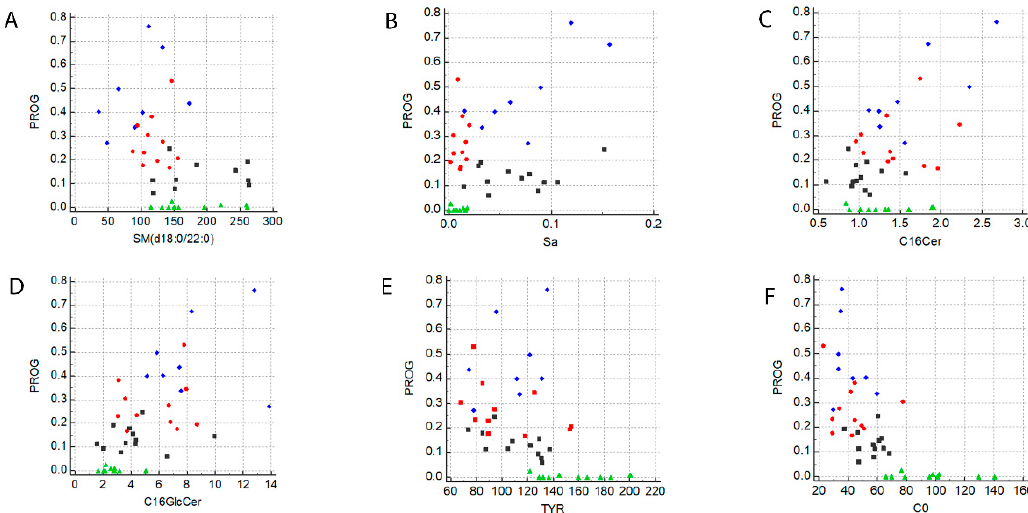
Figure 5. Panels ( A – F ) show the Rank correlations, performed by using MedCalc 7.6, between Progesterone (PROG), Sphingomyelin (d18:0/22:0) (SM), Sphinganine (Sa), Ceramide (d18:1/16:0) (C16Cer), Glucosylceramide (d18:1/16:0) (C16GlcCer), Tyrosine (TYR) and Free Carnitine (C0), respectively. The black squares indicate the first trimester of pregnancy, the red circles indicate the second trimester of pregnancy, the blue diamonds indicate the third trimester of pregnancy, and the green triangles indicate the post-partum period.